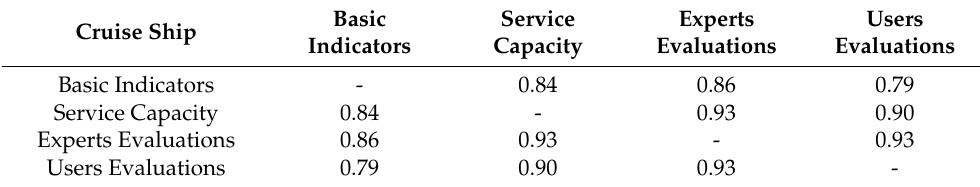
Table 13. The correlation of the star ratings among the four indicators for nine cruises. Cruise